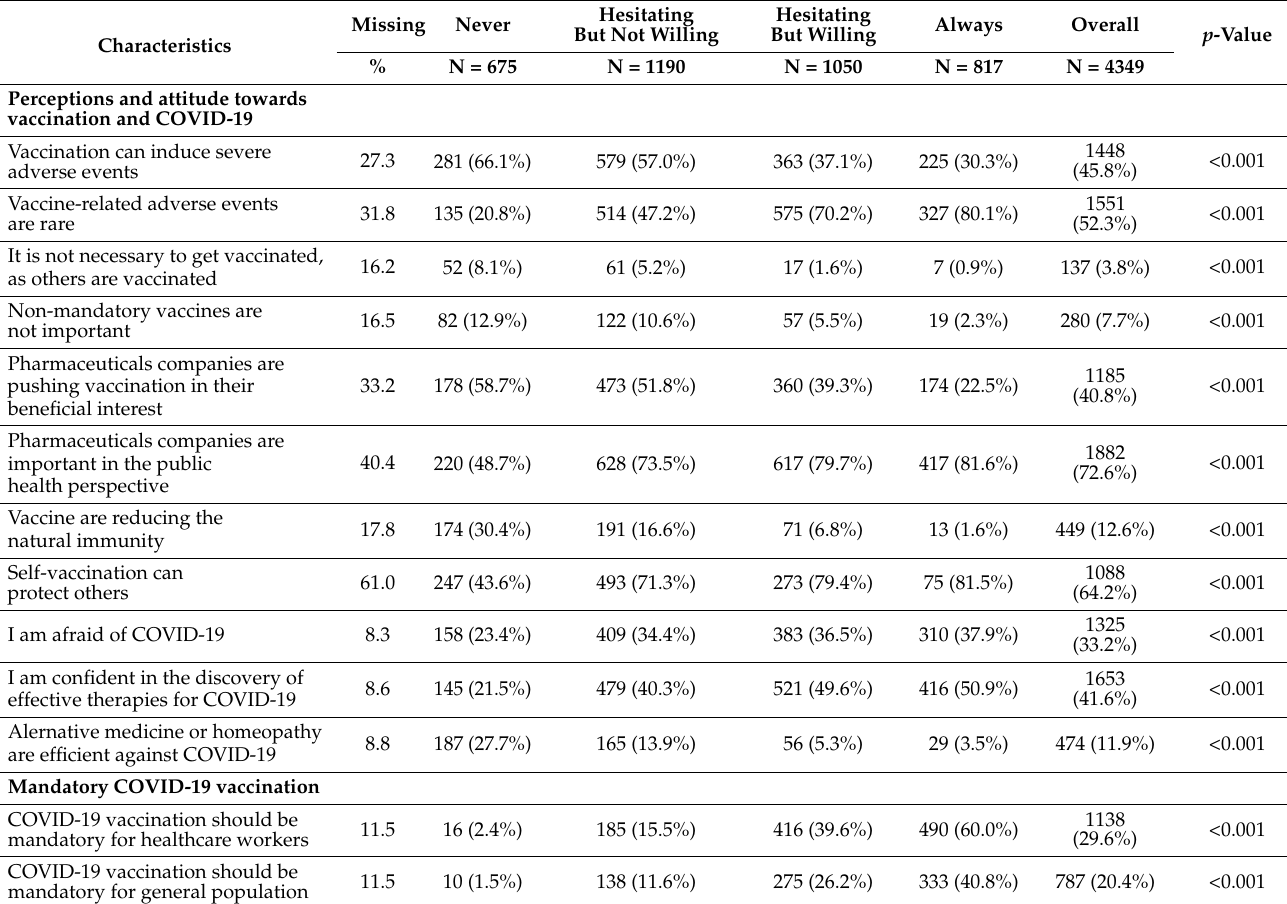
Table 2. Perceptions and beliefs towards vaccination, including